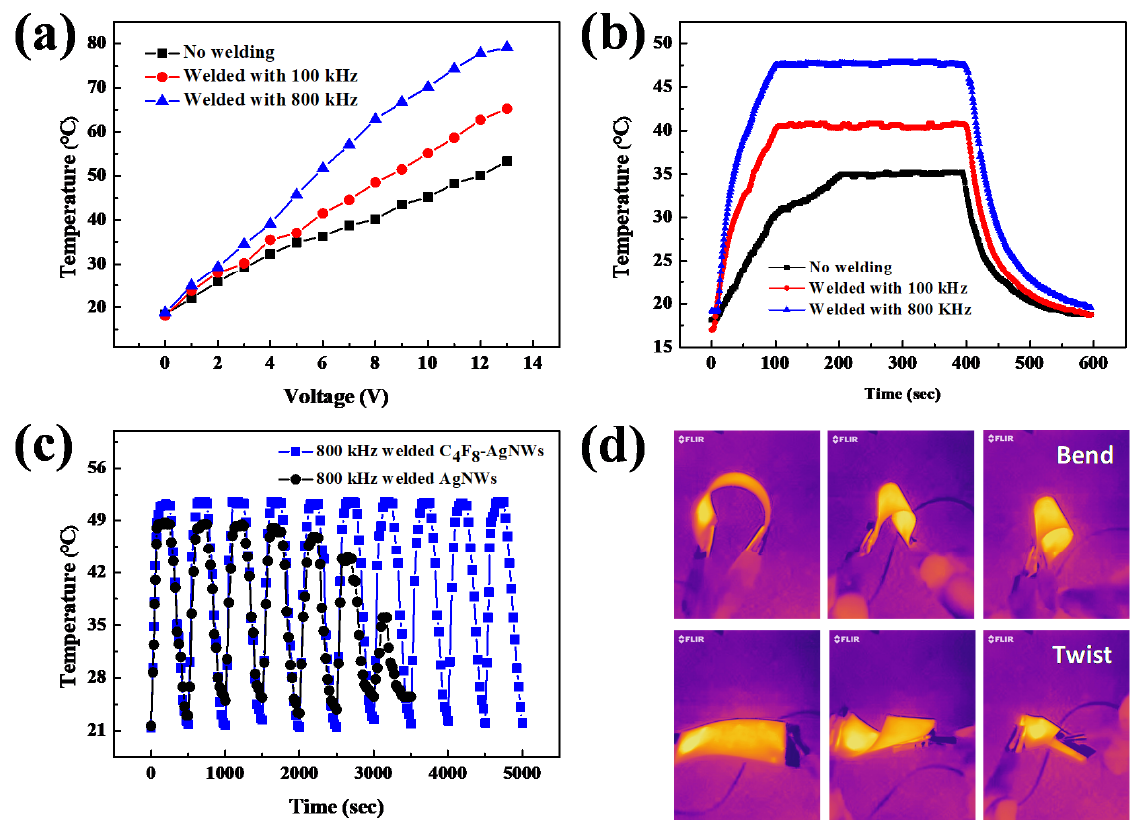
Figure 7. Ag NW THFs before and after welding at 100 and 800 kHz at 6 kW for 60 s. ( a ) Temperature of the THFs as a function of applied voltage. ( b ) Time-dependent temperature profile of the THFs at 6 V of applied voltage. ( c ) Temperature response of the THFs (welded at 800 kHz at 6 kW for 60 s) over 10 switching cycles with the applied voltage of 6 V (one cycle = 250 s on-time/250 s off-time) with, and without, a passivation layer formed by a C 4 F 8 plasma. ( d ) Thermal imagery of the Ag NW THFs welded at 800 kHz with the condition shown in ( a ). For ( c , d ), to protect the Ag NW network from the environment during the long-time exposure to atmosphere, the THFs were coated with a fluorocarbon polymer layer formed by a C 4 F 8